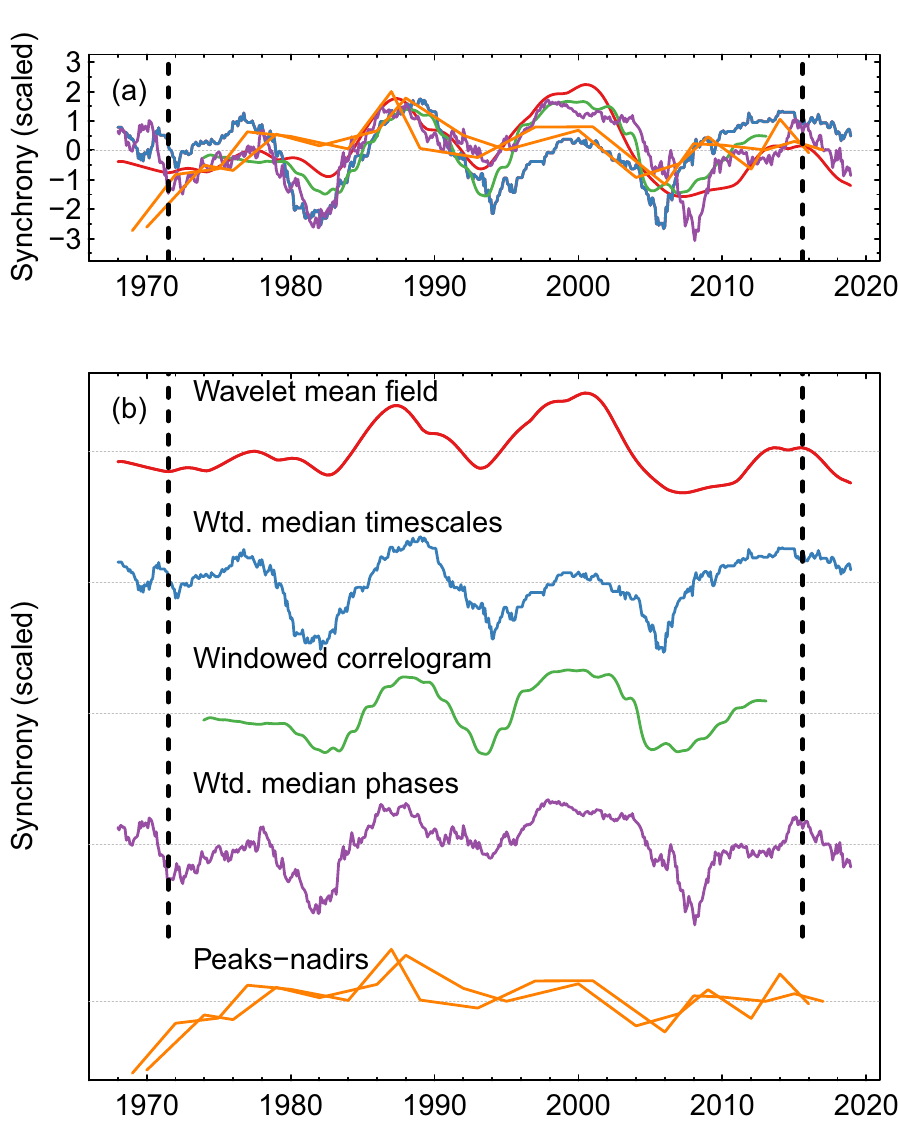
Fig 3. Comparison of all measures of synchrony in dengue. For details on these measures of synchrony, see section “Perspectives on synchrony” in S1 Appendix. The curve for WMFs was obtained by taking the mean WMF of Fig 2B across multiannual timescales, for each point in time. To facilitate comparisons, all metrics were normalised to have a mean of 0 and standard deviation of 1, and where necessary, time series were flipped along the y-axis so that higher values always equate to greater synchrony. Note that for the metric taken from the distribution of distances of peaks and nadirs, there are 2 time series in the same colour (one for peaks and another for nadirs). The 2 panels show the same time series, but (b) separates them for clarity. Edge effects in the WTs may influence results before and after the vertical dashed lines. The underlying data are in S1 Data at https://github.com/UF-IDD/synchrony_dengue_figures. WMF, wavelet mean field; WT, wavelet